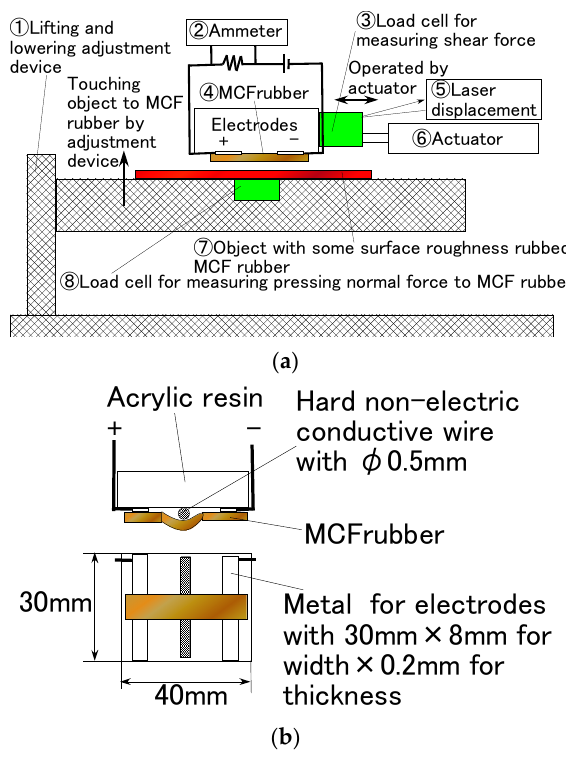
Figure 8. Schematic diagram of experimental apparatus used to investigate the electrical characteristics in the case of SFE: ( a ) overview; ( b ) the diagram shows details around the electrodes.